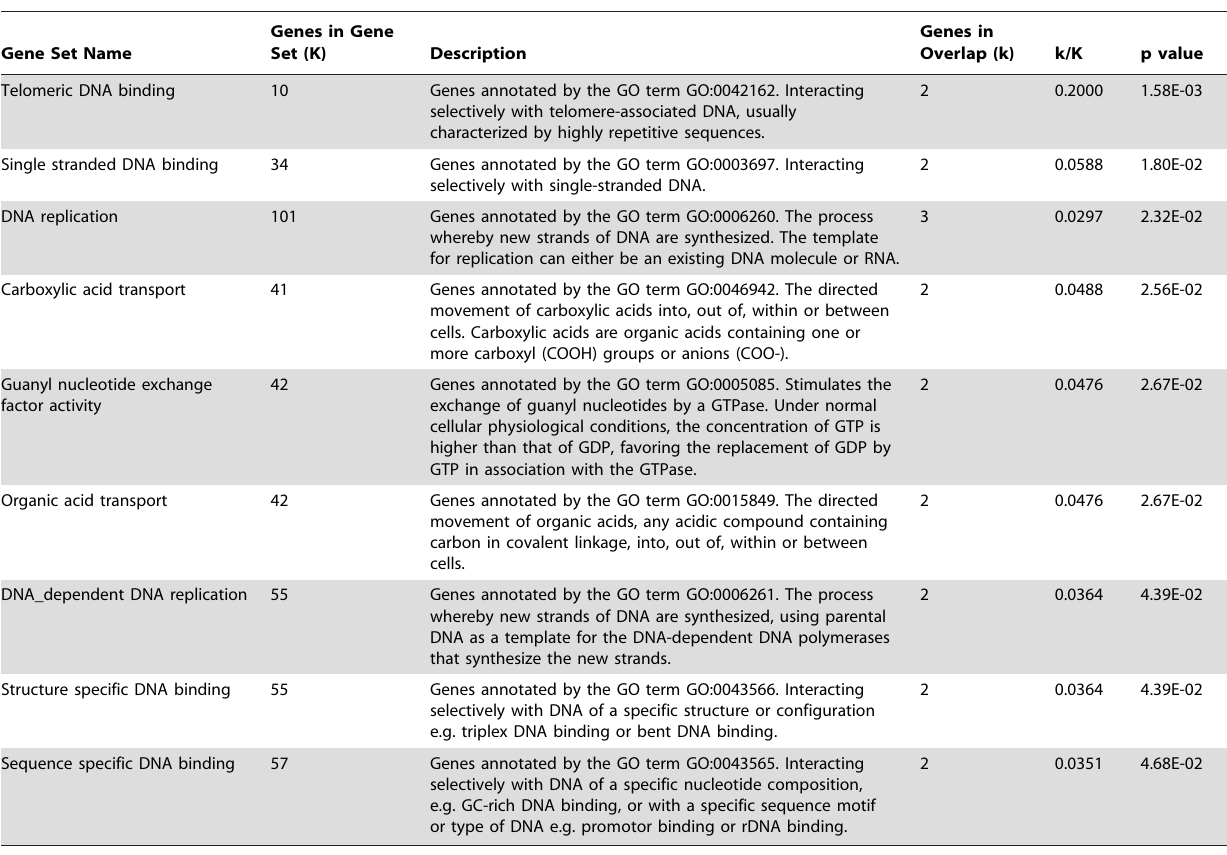
Table 4. Mostly potential GO functions of disorder model biomarker.